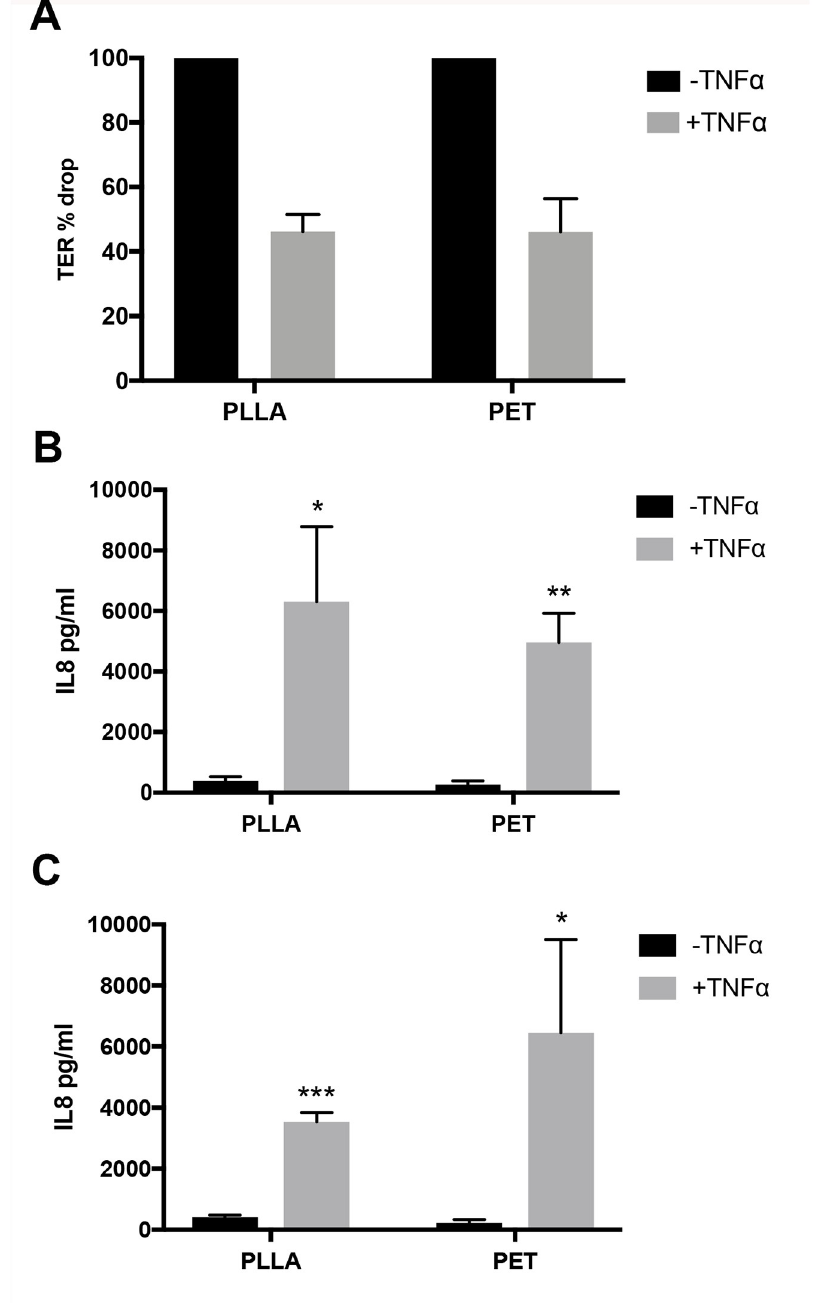
Fig 4. Comparison of the effect of TNF α on polarised epithelial cell layers cultures on PLLA or PET membranes. (A) TER percentage change after 24h treatment with TNF α . (B, C) IL-8 released into apical (B) or basolateral (C) conditioned media of cultures. Data are mean ± SD, n = 3 independent experiments each performed in